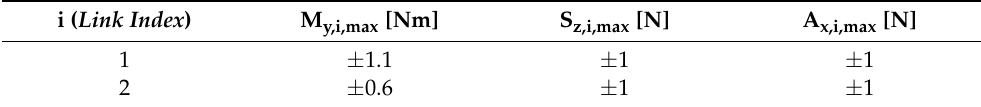
Table 1. Maximum non-null influence coefficients due to the unit force f e (Figure 3) of case